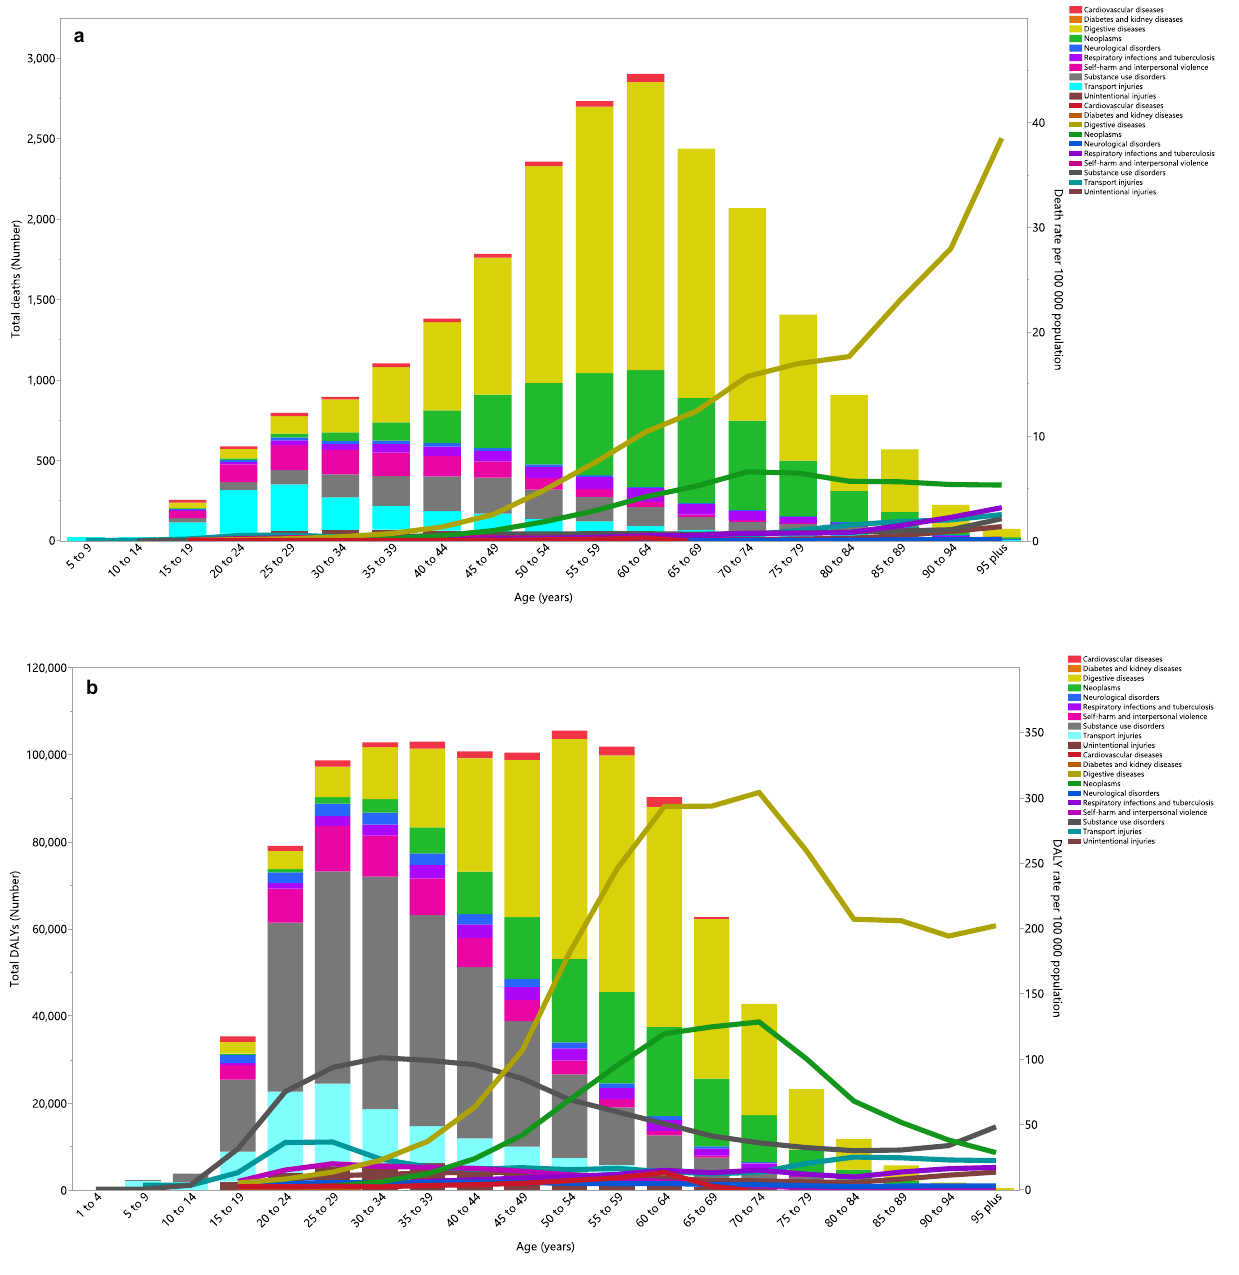
Figure 3. Numbers of deaths and death rate ( a ) and number of DALYs and DALY rate ( b ) of disease and injuries attributable to alcohol consumption in the Middle East and North Africa region, by age and cause in 2019 (Generated from data available from http:// ghdx. healt hdata. org/ gbd- resul ts-